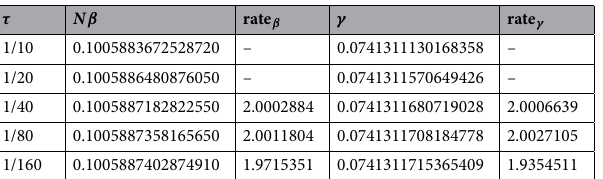
Table 2. Obtained values of the constants β and γ and the rate of convergence for four different values of the mesh spacing τ